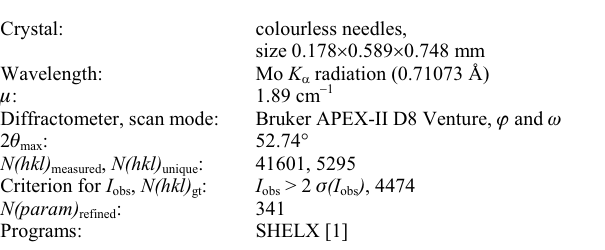
Table 1. Data collection and handling.